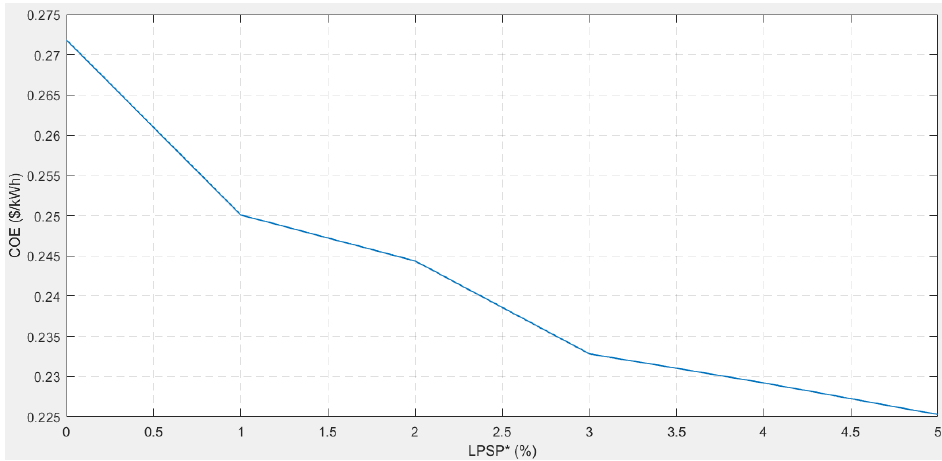
Figure 11. Sensitivity analysis result of the maximum loss of power supply probability ( LPSP* ).